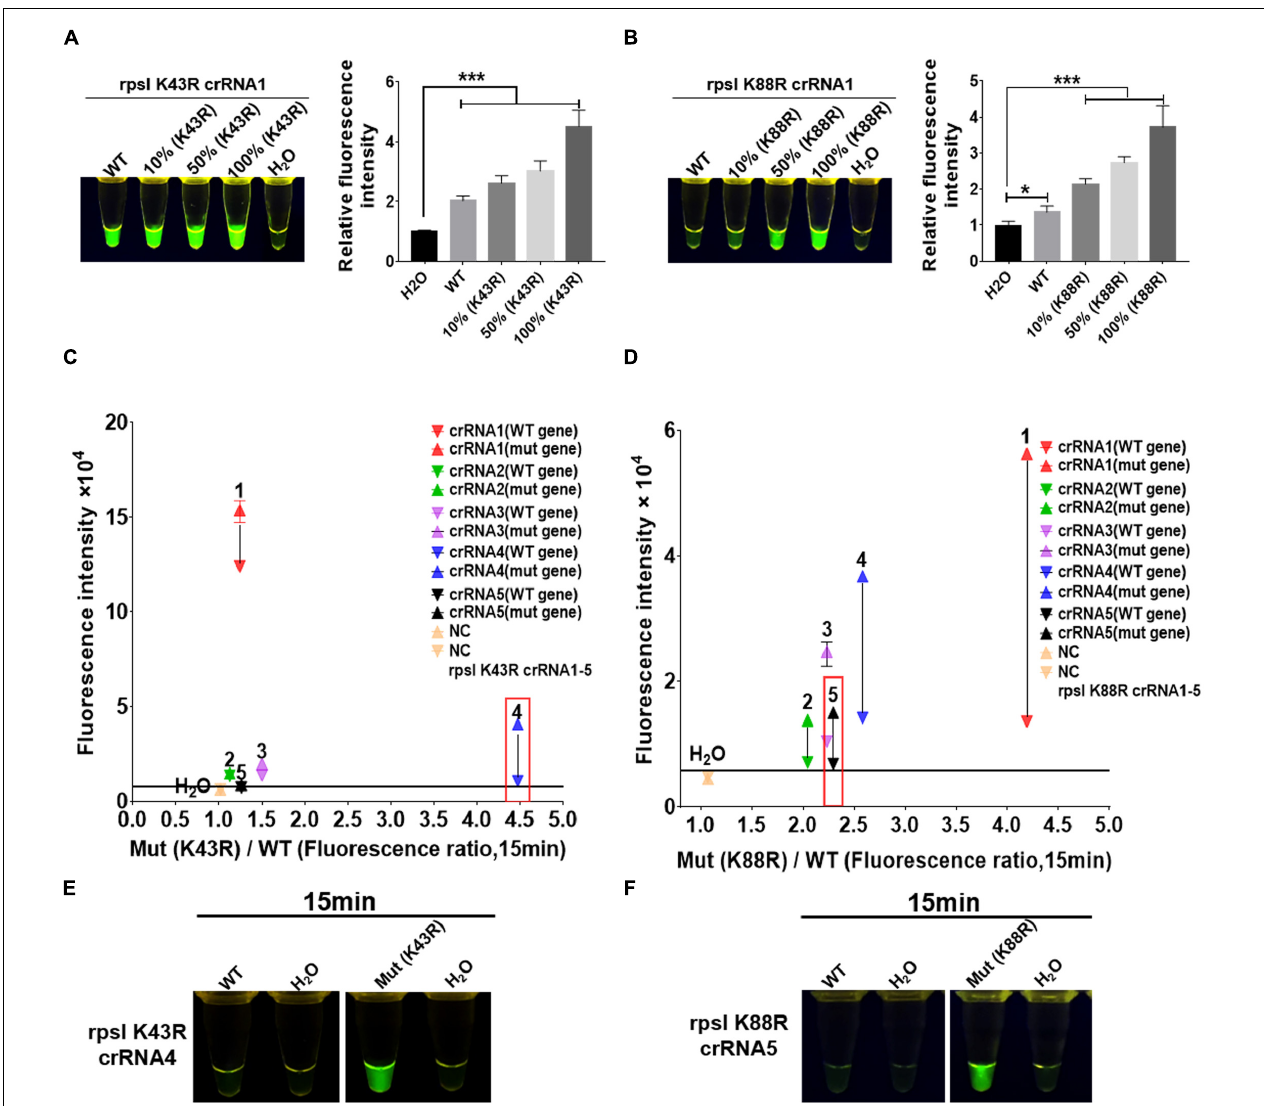
FIGURE 3 | Screening and optimization of the crRNA at rpsl K43R and rpsl K88R streptomycin (STR)-resistant mutation sites. The Cas12a RR system detects the efficiency of the rpsl gene-specific crRNA of STR-resistant M.tb . The fluorescent images and intensities (A,B) at 15 min of the reaction are shown. The rpsl gene fragments of wild-type M. tuberculosis and streptomycin-resistant M. tuberculosis (K43R or K88R) were mixed in different proportions to obtain the detection samples with mutation rates of 100, 50, and 10%, respectively. (C,D) Specificity was determined as the ratio of the on-target DNA-induced fluorescence intensity over the off-target DNA-induced fluorescence intensity. The fluorescence intensity was obtained from crRNA–Cas12a RR reaction for 15 min and measured using a microplate reader. The core crRNA sequences are listed in Supplementary Table 2 . (E,F) The Cas12a RR system verifies the specific crRNA of the STR-resistant M.tb rpsl gene fragment and shows the fluorescence image at 15 min of reaction. The concentration of the target gene used in the above-mentioned detection reaction is 1 × 10 11 copies. Data are presented as the mean ± SEM from at least three independent experiments. * p < 0.05, ** p < 0.01, *** p < 0.001, and **** p <